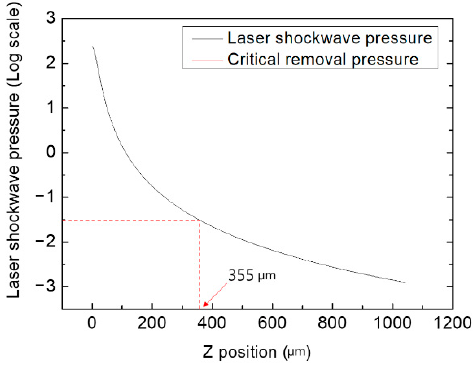
Figure 16. Effective laser cleaning maximum distance by theoretical prediction.